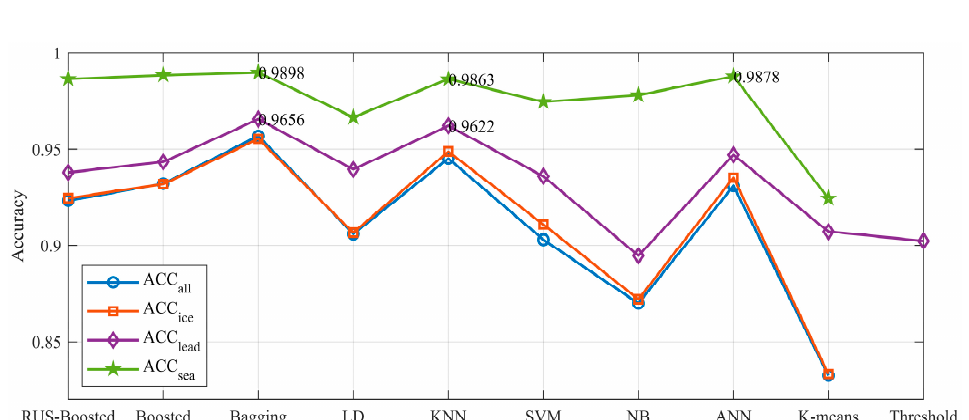
Figure 11. Classification accuracy of different classifiers. The blue line is overall accuracy. The green line is ocean accuracy. The red line is sea ice accuracy. The purple line is ice lead accuracy.